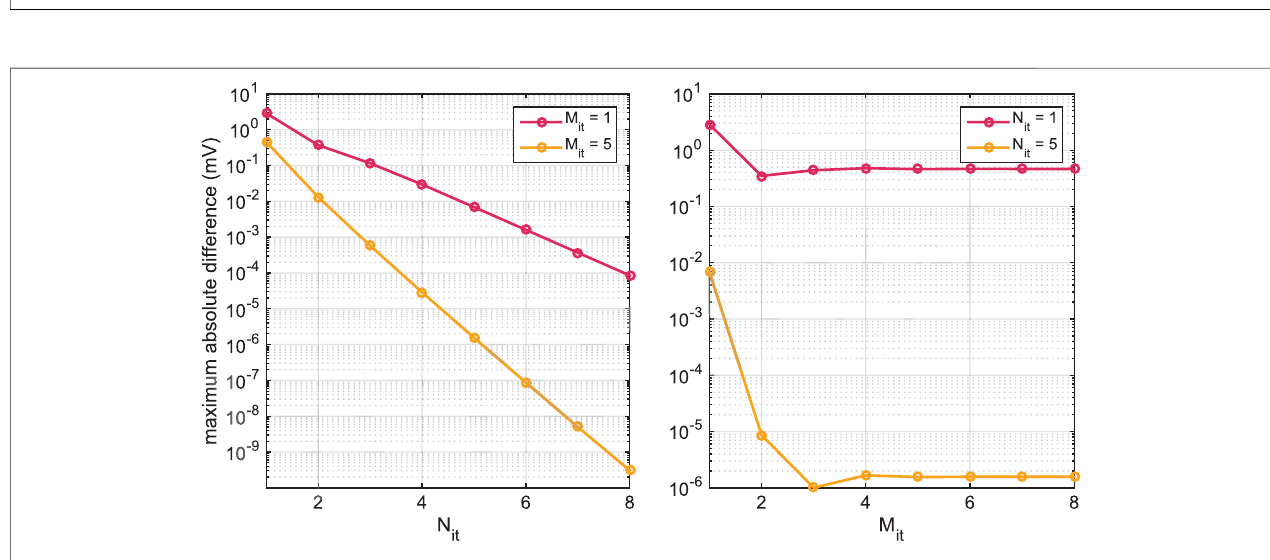
FIGURE12| Maximumabsolutedifferencein u i at t (cid:2) 2 . 5 mscomputedusingthecoupledandsplittingapproachesasthenumberofouterandinneriterations, N it and M it ,areincreased.Intheleftpanel,weincreasethenumberofouteriterations, N it ,andconsiderthetwocases M it (cid:2) 1and M it (cid:2) 5.Intherightpanel,weincreasethe number of inner iterations, M it , and consider the two cases N it (cid:2) 1 and N it (cid:2) 5. The parameters used in the simulations are speci fi ed in Tables 1 and 3